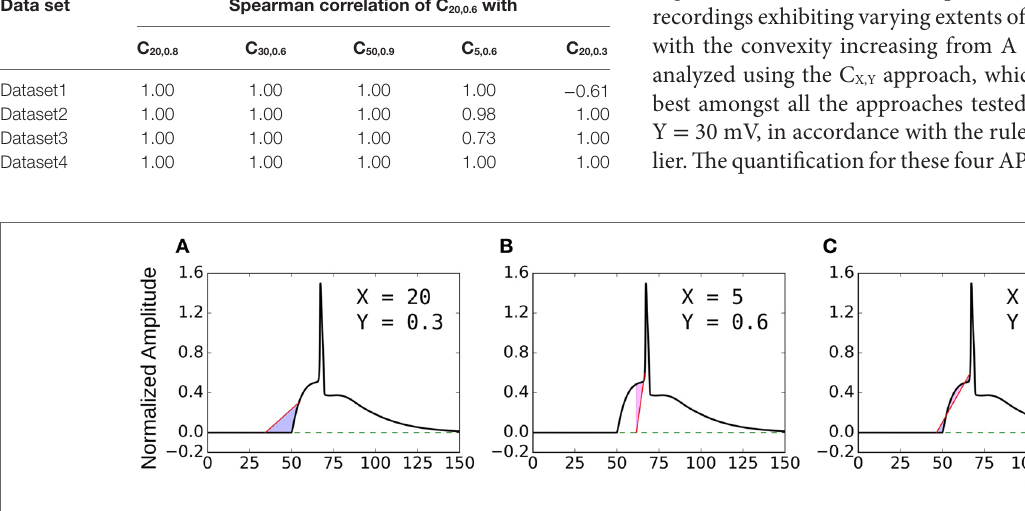
tABLe 4 | Comparing correlations of C X,Y for different combinations of X, Y parameter values with C 20,0.6 . data set spearman correlation of C 20,0.6 with